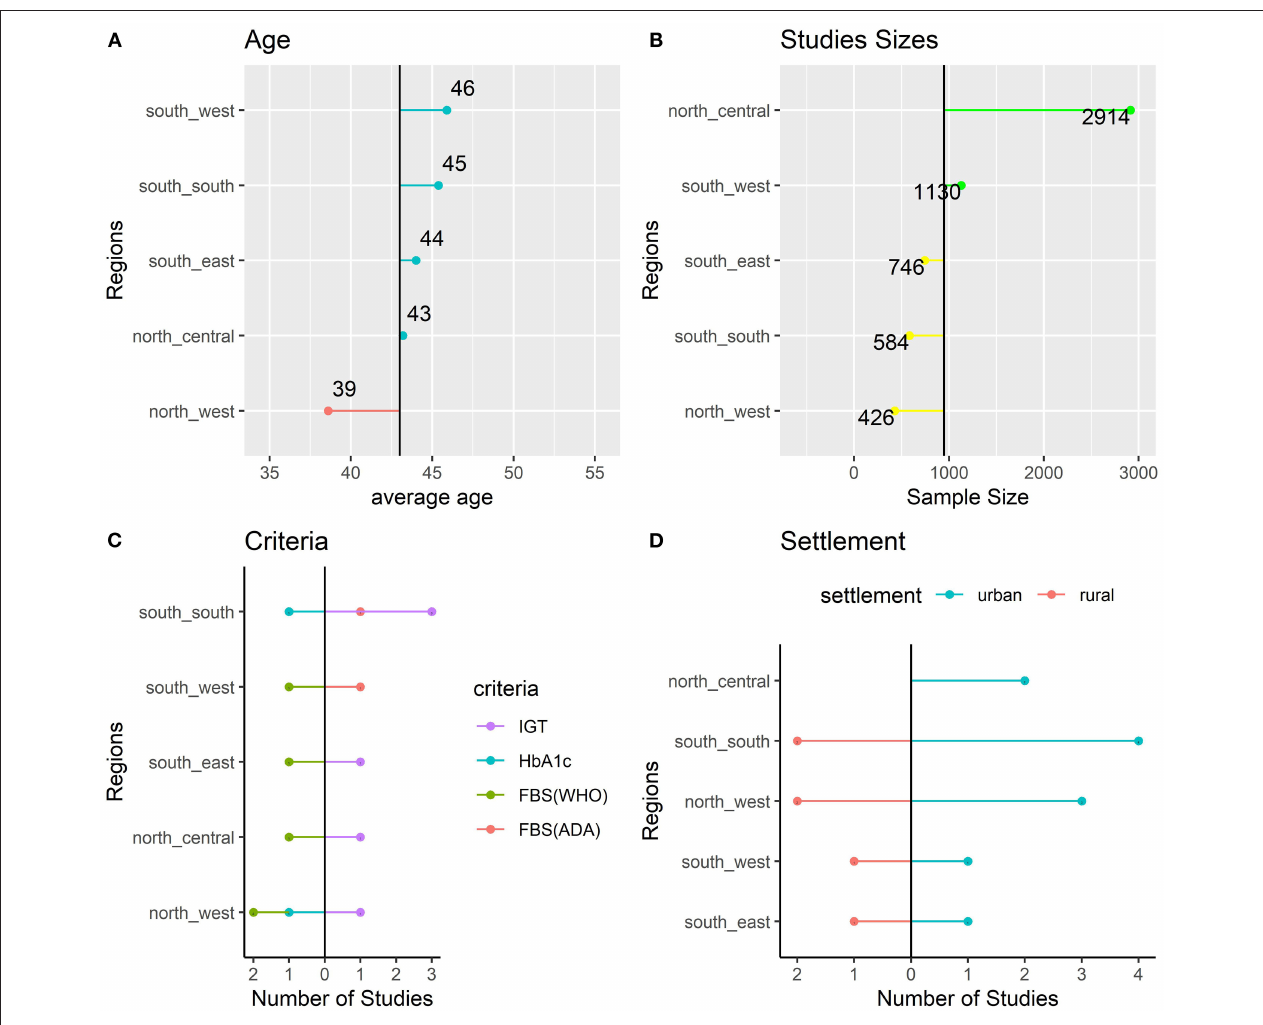
FIGURE 3 | Characteristics of the Included Studies: age (A) , sample size (B) , criteria (C) , and settlement (D)